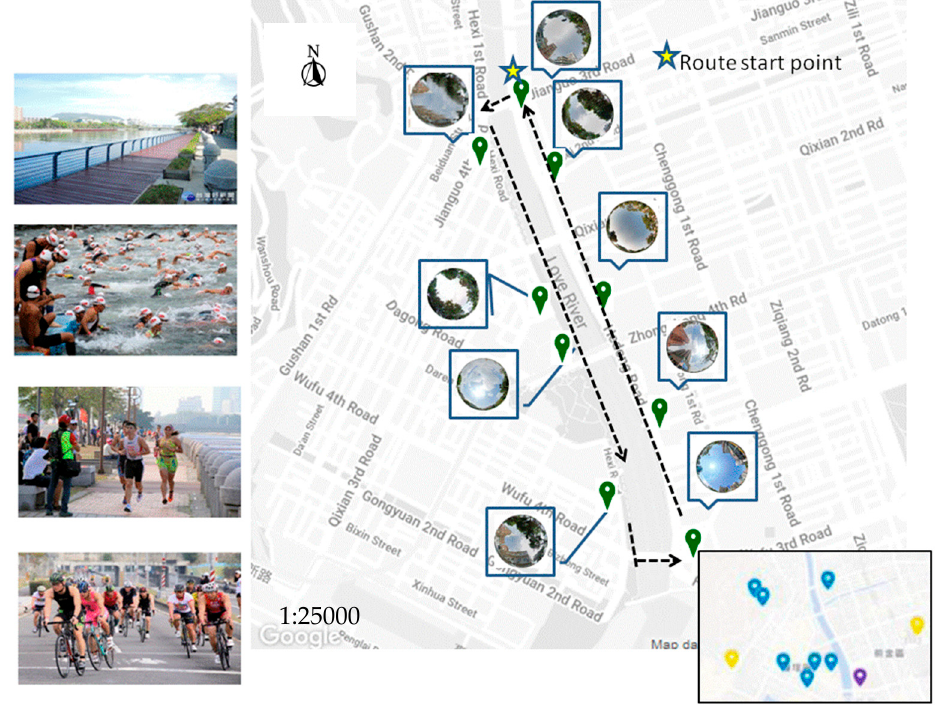
Figure 4. Spring running event route, activity photos, and fisheye photos.